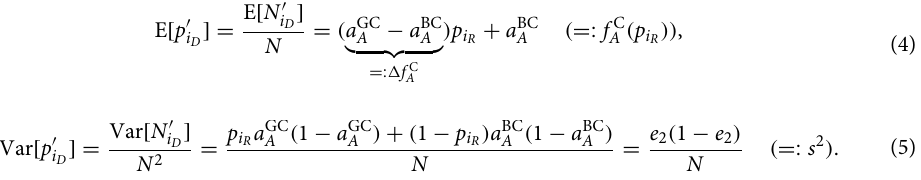
observers who assign good reputations to recipient i R at the present time step. There, a GC A R indicates the probability that an observer who assigns a good (G) reputation to the recipient at the present time step assigns a good reputation at the next time step to the donor who cooperates (C) with that recipient under social norm A . The values of a GC A can be calculated for each social norm A , and they are shown in Table 2. The second term in the right side of Eq. (3) is the number of individuals who assign good reputations to donor i D at the next time step among N